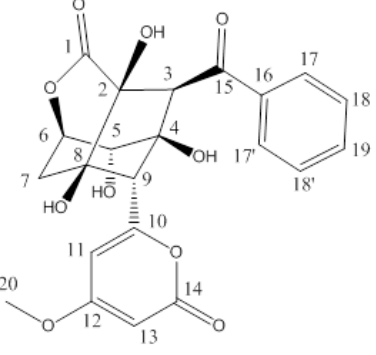
Figure 1. Chemical structure of enterocin.